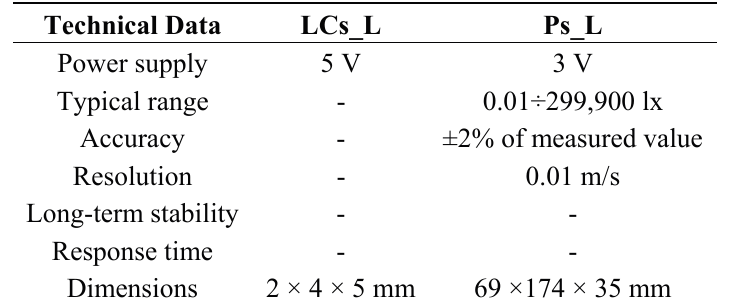
Table 7. Technical specifications sensors used to measure